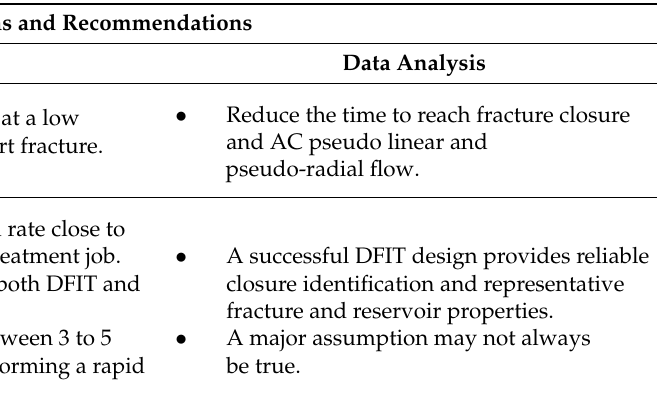
Table 8. Important points that extended in planning, executing, and achieving the successful